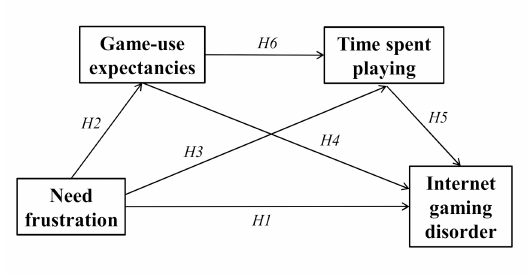
Figure 1. The mediation